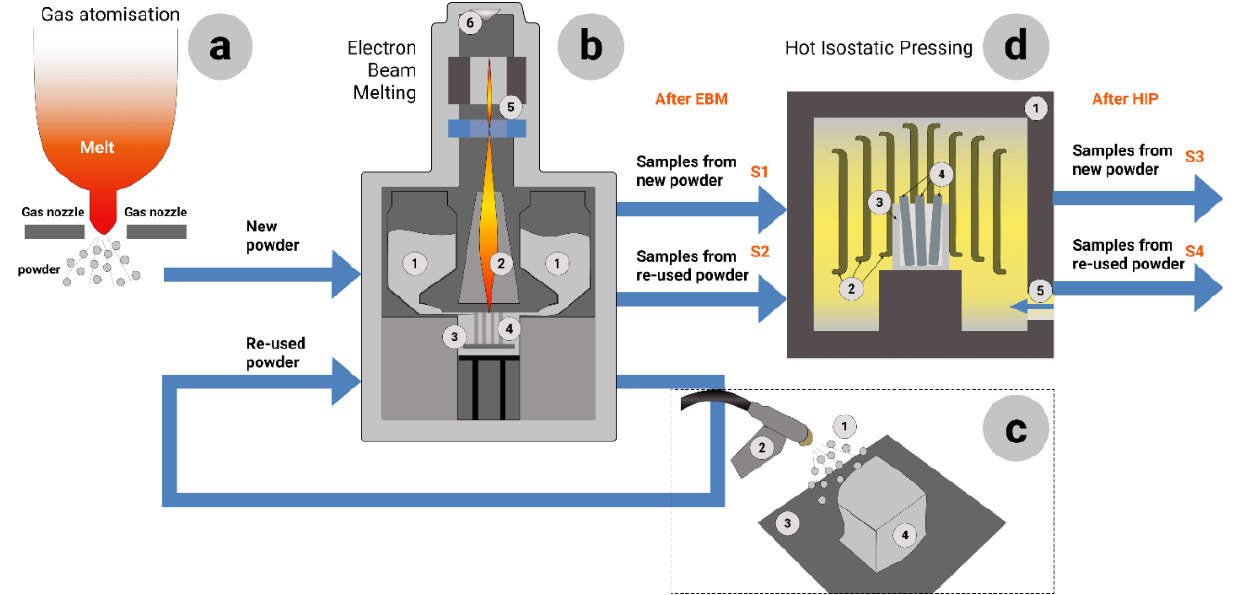
Figure 1. Flow of processing and experiment: ( a )—Ti-6Al-4V powder gas atomization; ( b )—electron beam melting, where 1 stands for powder in hoppers; 2—high-power electron beam; 3—building platform; 4—additively manufactured cylindrical samples in powder bed; 5—focus and deflection coils; 6—cathode grid; ( c )—powder recovery system (PRS) for cyclic use of the powder, where 1 stands for Ti-6Al-4V powder; 2—powder spray gun; 3—building platform; 4—semi-sintered powder bed with samples inside; ( d )—hot isostatic pressing (HIP), where 1 stands for internal chamber of the HIP furnace; 2—heating elements; 3—container; 4—additively manufactured cylindrical samples.